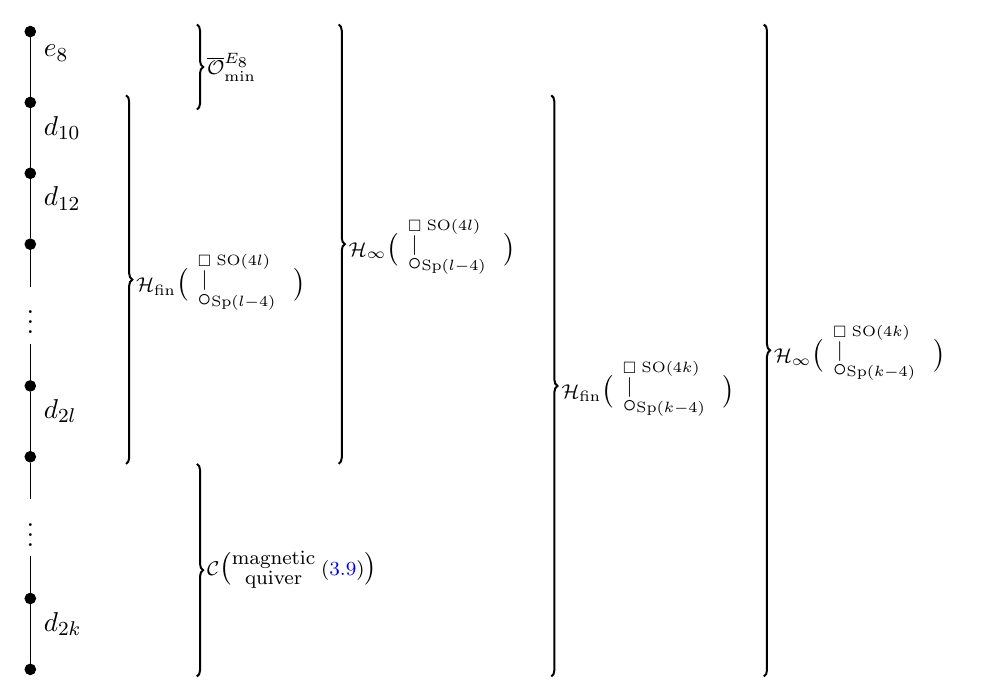
Figure 1 . The Hasse diagram for the Higgs branch of (2.6) at in(cid:12)nite gauge coupling. There are two types of minimal transitions: (cid:12)rstly, the e 8 transition, i.e. the transverse slice is the closure of the minimal nilpotent orbit of E 8 . Secondly, various d 2 l transitions, i.e. the transverse slice is